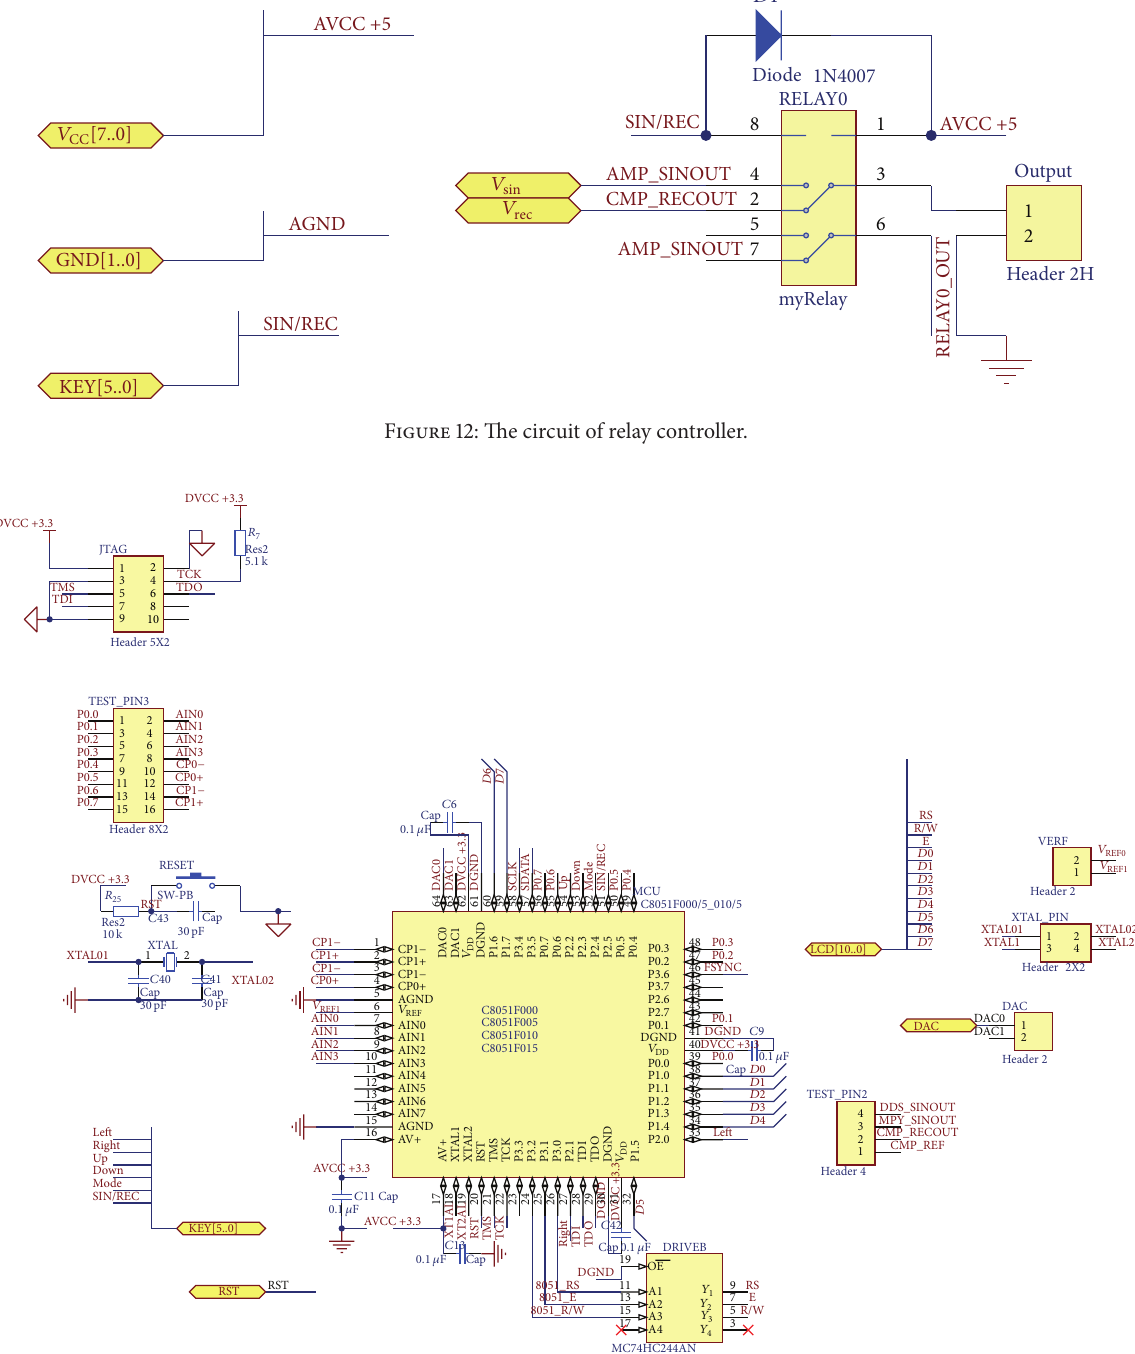
Figure 13: The controlling circuit of